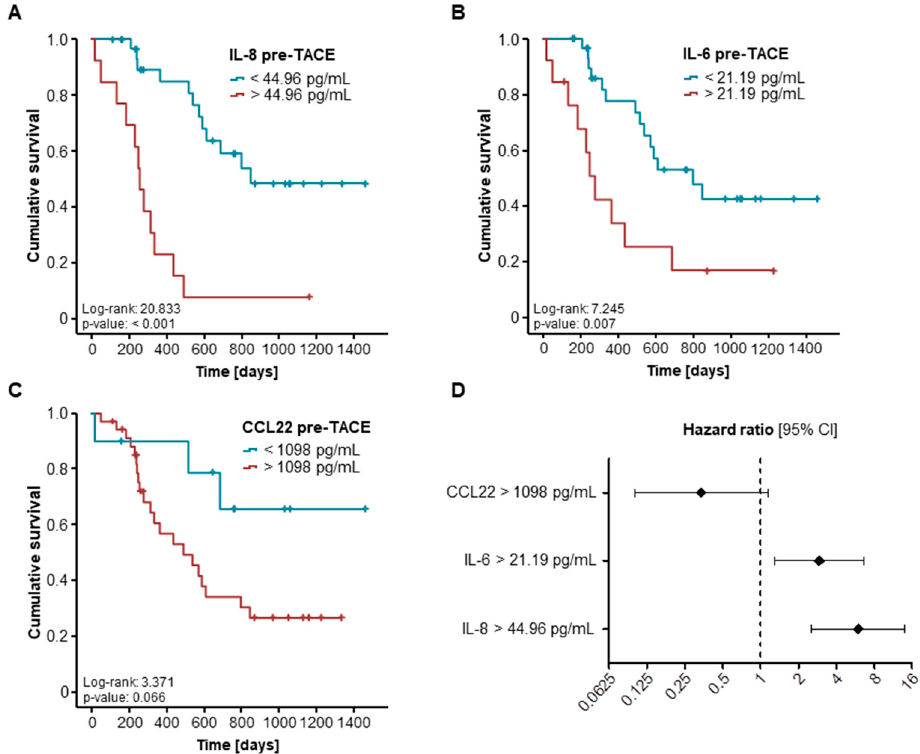
Figure 3. High pre-interventional serum levels of IL-6 and IL-8 are associated with an unfavorable prognosis after TACE. ( A ) Patients with IL-8 serum levels above our defined ideal cut-off value show a significantly impaired long-term survival; ( B ) Pre-interventional IL-6 serum levels discriminate between patients with good and poor prognosis; ( C ) Serum CCL22 levels are unsuitable for the prediction of long-term survival; ( D ) Univariate Cox regression analysis reveals circulating IL-6 and IL-8 but not CCL22 levels as prognostic factors (black diamond: odds ratio, error bars: 95% confidence interval (CI).